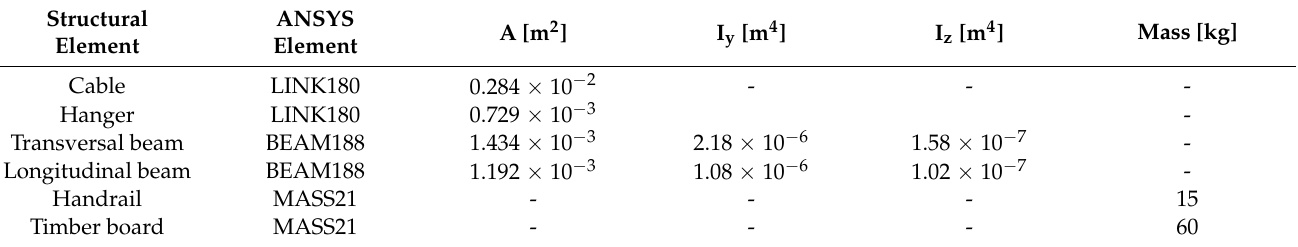
Table 6. Element properties.